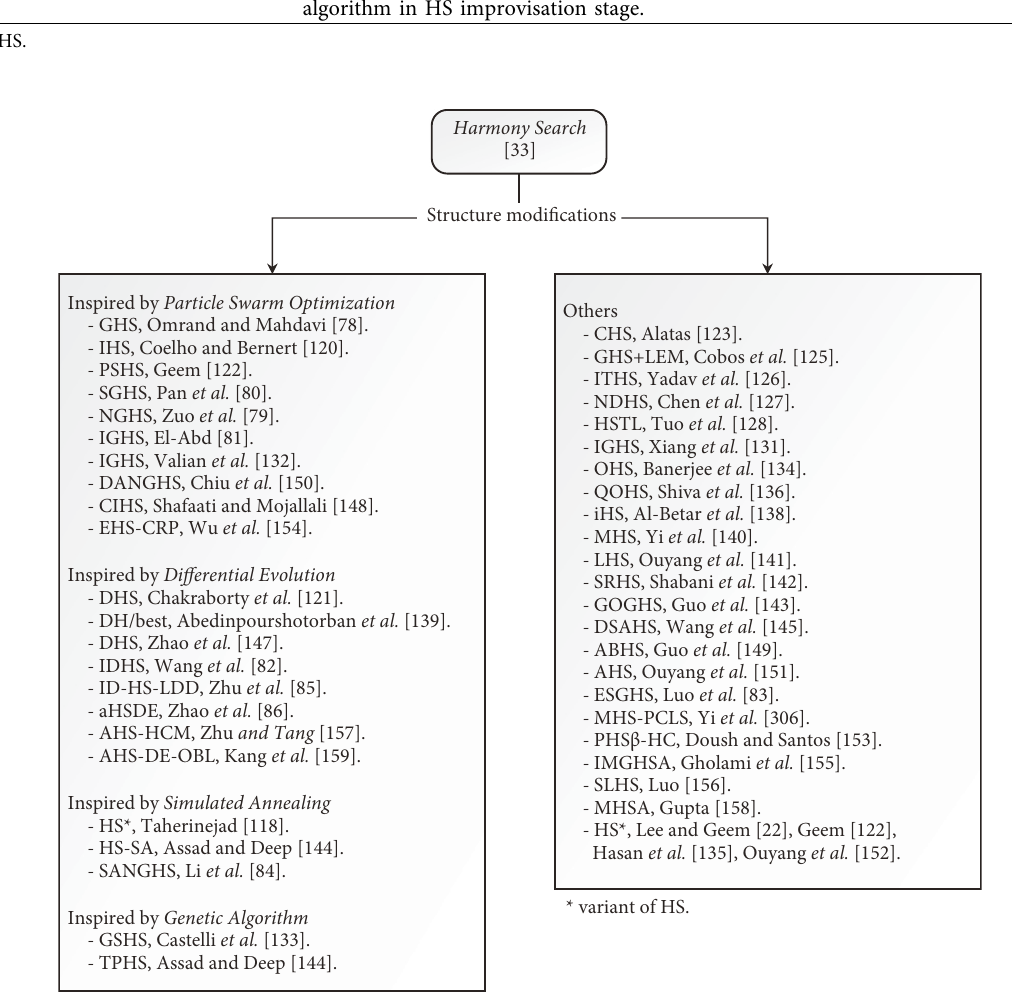
Figure 3: Harmony search variants grouped by the structure-based